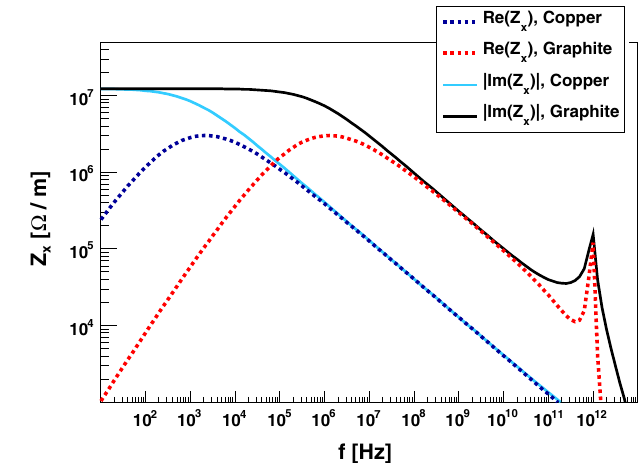
FIG. 2. (Color) Real and imaginary transverse wall impedance for the case of an LHC graphite collimator at injection energy FIG. 3. (Color) Real and imaginary transverse wall impedance ¼ 1 , L ¼ with b ¼ 2 mm , (cid:3) dc ¼ 10 (cid:2) (cid:2) m , (cid:7) ¼ 0 : 8 ps , " for the case of an LHC collimator at injection energy with b ¼ b ¼ 1 , and tan ð # Þ ¼ 0 , assuming 1 m , (cid:11) ¼ 480 , a ¼ 10 (cid:2) m , (cid:2) 2 mm assuming infinitely thick jaws of copper (dashed blue and r M 2.5 cm jaws surrounded by vacuum (solid black and cyan lines) solid cyan lines) and of graphite (dashed red and solid black and infinitely thick graphite jaws (dashed red and blue lines). lines). The other parameters are those of Fig. 2, except for the dc Note that the (dipolar) Yokoya factor for a flat chamber ( (cid:5) 2 = 12 ) resistivity and relaxation time of copper: (cid:3) dc ¼ 1 : 7 (cid:5) 10 (cid:1) 8 (cid:2) m has been applied. and (cid:7) ¼ 2 : 7 (cid:5) 10 (cid:1) 14 s .